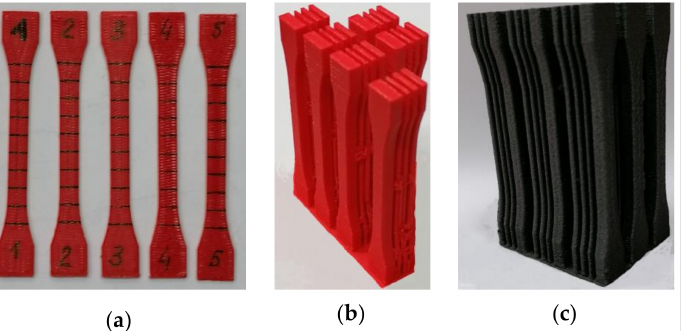
Figure 3. Examples of prints ( a ) marked PLA specimens (orientation along the x axis); ( b ) multiple PLA specimens made in one print (orientation along the z axis); ( c ) multiple PLA-CF specimens made in one print (orientation along the z